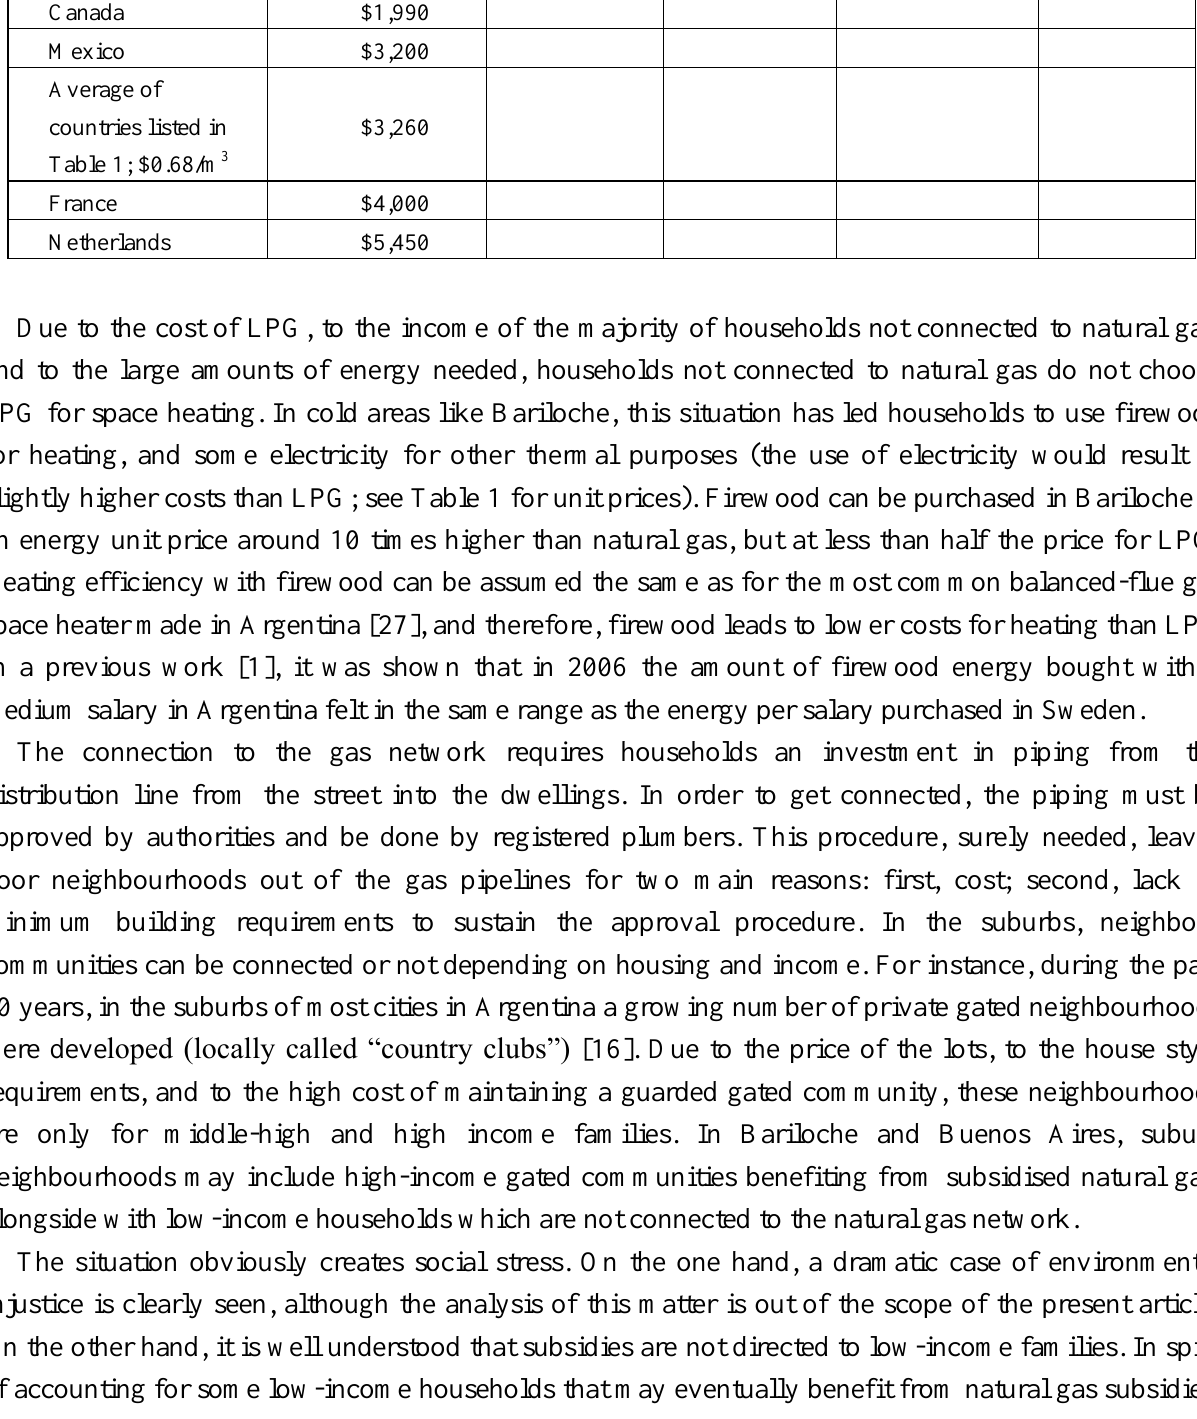
Cost for the use Cost for the Cost for the Cost of gasoline Cost of a of 4800 m 3 of use of 3750 use of cable for a medium basic car’s natural gas in kg of LPG in TV during car driving insurance households households one year 10,000 km liability $125 $3,000 $400 $700 $300